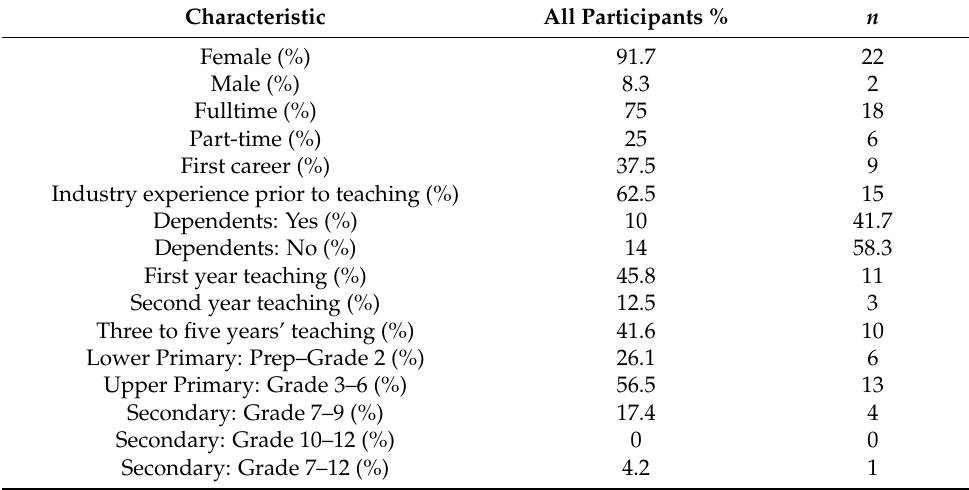
Table 2. Participant characteristics ( n =